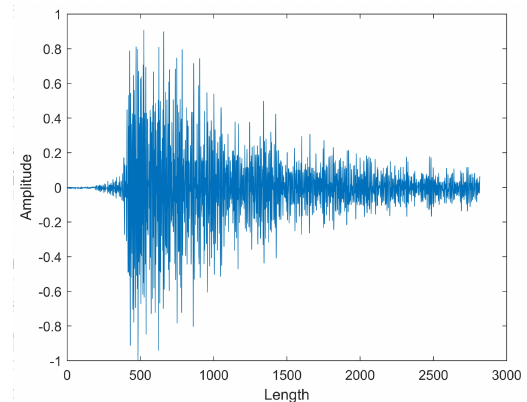
Figure 1. The pulse sound